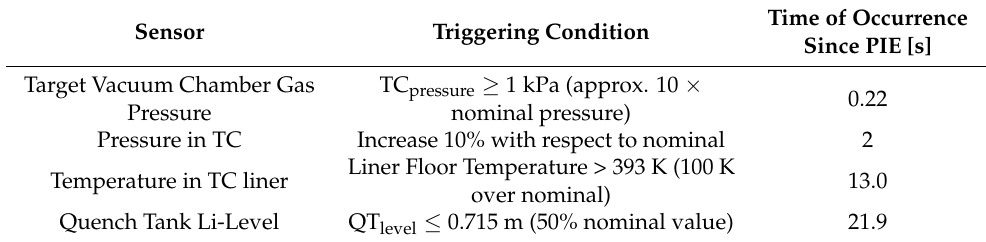
Table 4. Accident detection.